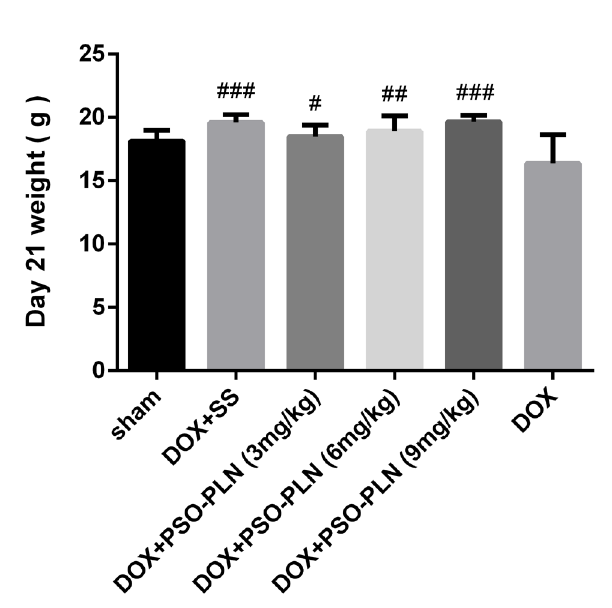
FIGURE 2 - Change in the body weight at day 21 in mice.